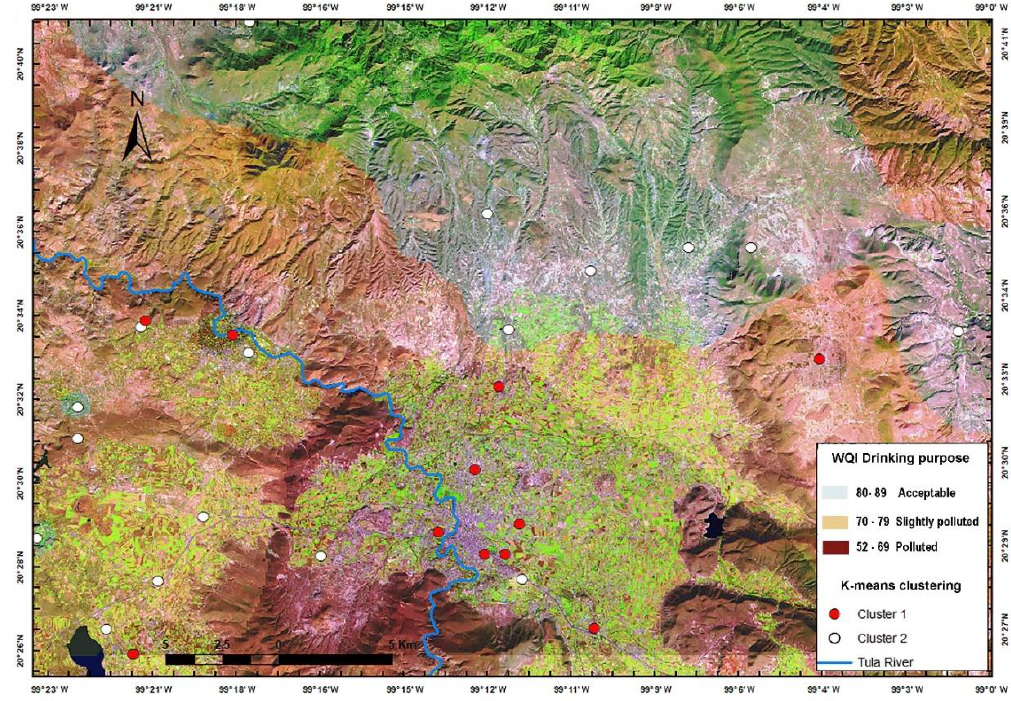
Figure 3. Spatial overlap between the distribution of groundwater quality and the clustering of sampling sites.